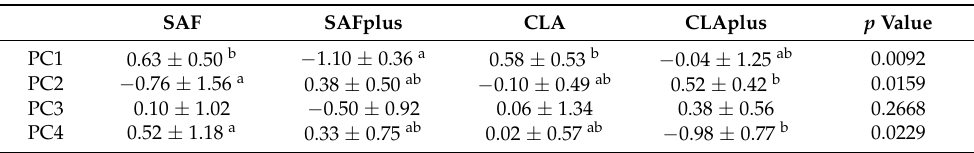
Table 4. The comparison of experimental groups regarding identified